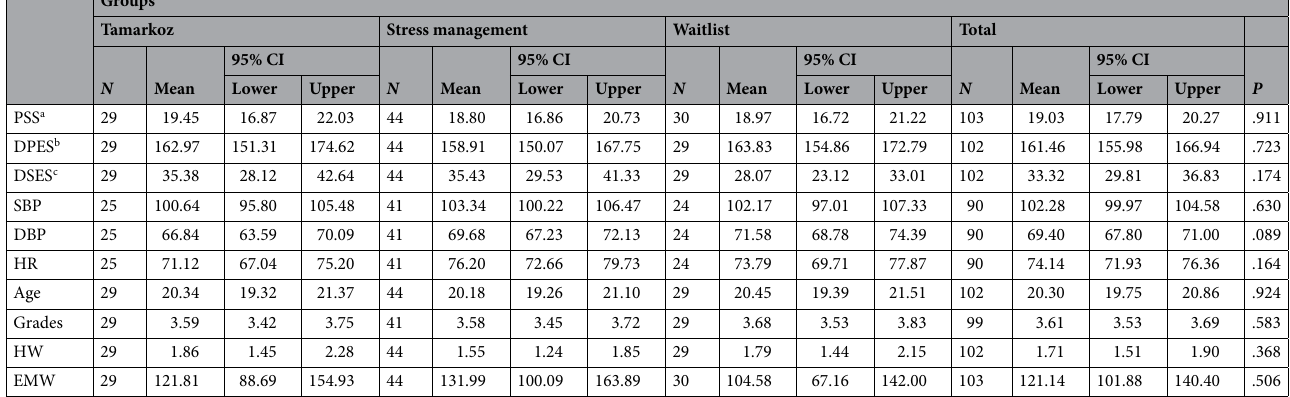
Table 4. Continuous demographic and baseline outcome variables. DSES Daily Spiritual Experiences Scale, DPES Dispositional Positive Emotions, PSS Perceived Stress Scale, SBP Systolic Blood Pressure, DBP Diastolic Blood Pressure, HR Heart Rate, HW Hours Worked, EMW Exercise minutes/week. a Range was from 0 for lowest to 40 for highest stress. b Range was from 38 for lowest to 266 for highest positive emotions. c Range was from 16 for lowest to 94 for highest daily spiritual